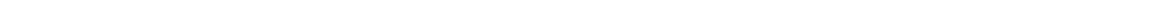
Fig. 3 Assessment of SCV iron content in the presence or absence of FPN. a Expression of the iron biosensor in the presence or absence of iron chelator (2,2 ′ -bypyridyl, 0.2 mM) in vitro. All Salmonella were stained with DAPI (blue), and iroBp-gfpOVA -expressing Salmonella are green. b Salmonella growth was determined in RPMI 1640 supplemented with the indicated concentration of FeSO 4 (0.005 – 500 μ M). Bacterial cell mass ( A 600 ) was measured at the indicated times. c Expression of iroBp-gfpOVA at 2 h p.i. in Salmonella grown as in b was quanti fi ed as the percentage of GFP + Salmonella , as shown in a . Data are presented as means ± SEM. Signi fi cance is indicated as **** p < 0.0001 by two-tailed Student ’ s t -test. d , f Nuclei were stained with DAPI (blue), Salmonella with a speci fi c antibody (red), and iroBp-gfpOVA expression is shown in green. d Expression of iroB-gfpOVA was determined in the Salmonella (MOI, 100) infecting Raw264.7 cells pretreated with PBS, hepcidin (1 μ g/ml), FeSO 4 (0.1 mM), or DFO (100 μ M). Images were taken 2 h p.i. by confocal microscopy. f Expression of iroB-gfpOVA in the Salmonella infecting C57BL/6 mice treated with GSK5182 (FPN + ) or PBS (FPN - ). Representative images of spleens infected with Salmonella were examined by confocal microscopy 2.5 days after i.v. infection (1 × 10 5 CFU). Scale bars 10 μ m. e , g The fraction of iroBp-gfpOVA -expressing (green) Salmonella shown in d , f was quanti fi ed, respectively, as in b . Data are presented as means ± SEM. Signi fi cance is indicated as *** p = 0.0004; **** p < 0.0001 by two-tailed Student ’ s t